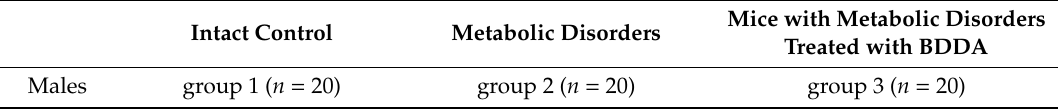
Table 1. Groups of animals in the experiments in vivo .